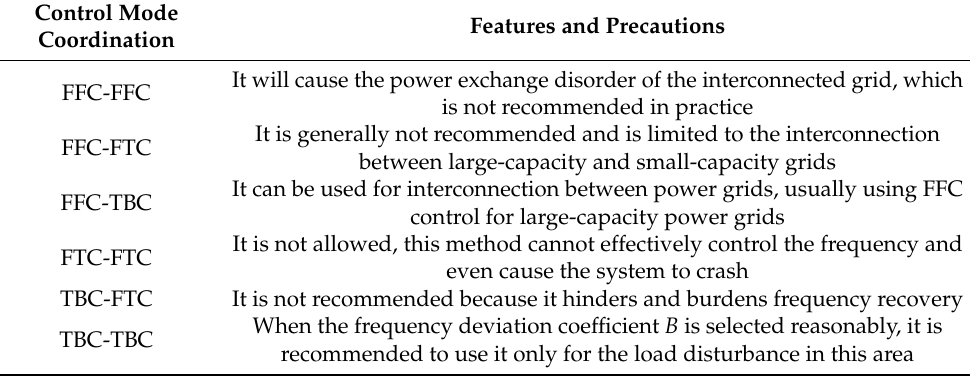
Table A1. Cooperate with AGC control mode of interconnected power grid.